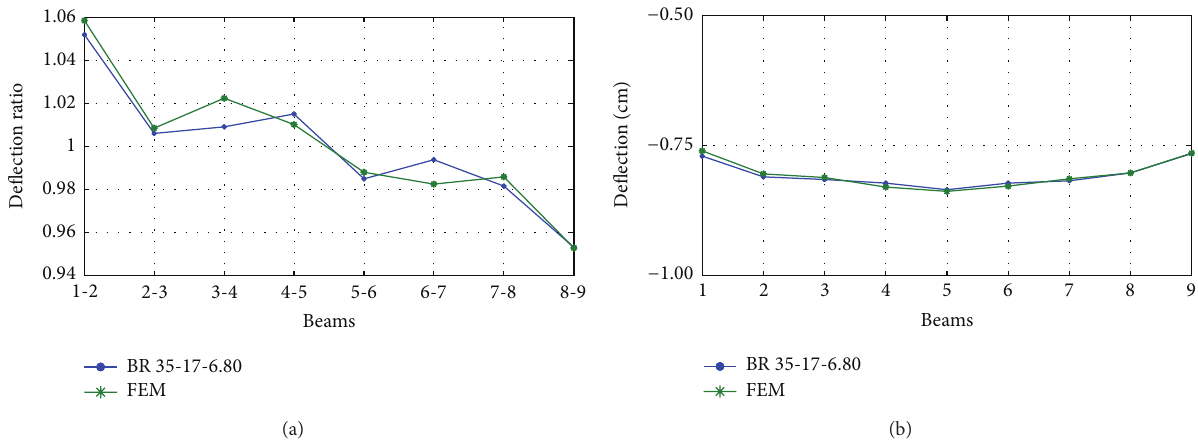
Figure 5: Comparison of (a) deflection ratios and (b) deflections for single span bridge model and end span of BR 35-17-6.80. and shear key stiffness adjusted to reflect the load-deflection behavior of the real bridge, the rotational springs at the end of the bridge model were removed. The resulting single span bridge model with pinned end conditions was taken to represent the damaged state of the bridge and was used for analysis. In order to obtain an undamaged bridge model, the modulus of every beam, as well as the stiffness of every vertical spring, was taken to be the largest value determined from the damaged bridge